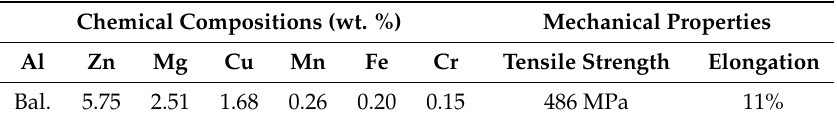
Table 1. Chemical compositions and mechanical properties of 7B04-T74 aluminum alloy. Chemical Compositions (wt.